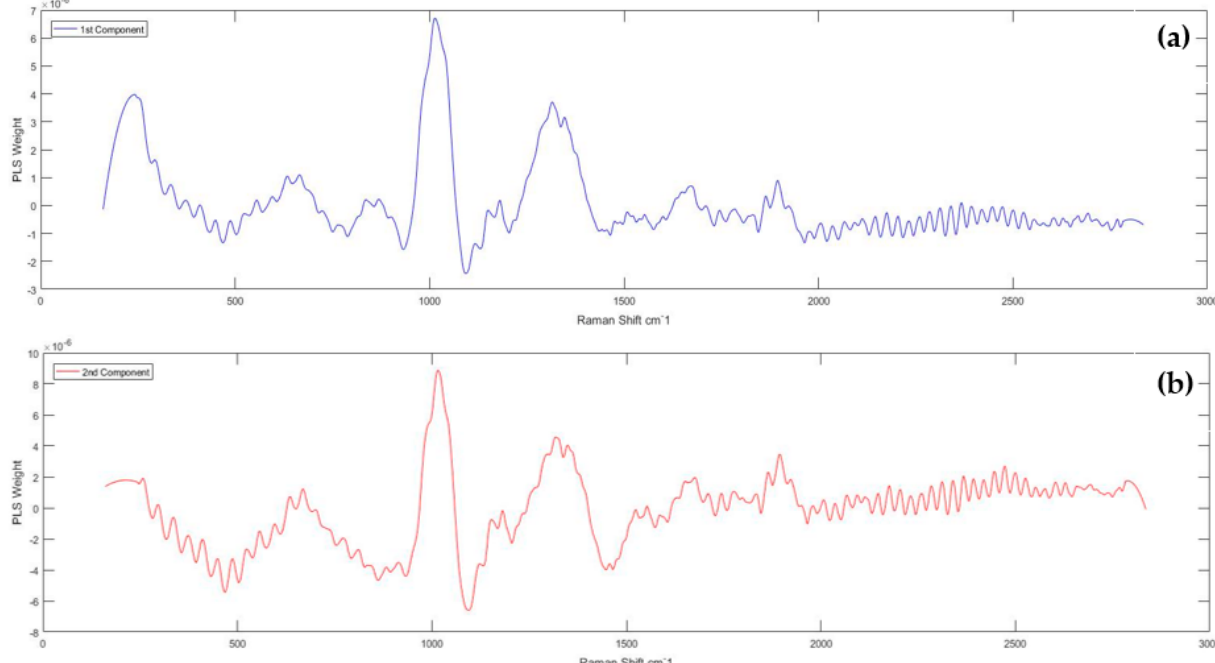
Figure 5. Weight plots from bicarbonate calibration model (4 molar MEA) for ( a ) PLS Component 1 and ( b ) PLS Component 2. The results from performance evaluation are further supported by observing the regression plots. A good model shall have the datapoints distributed along the regression line. Examples of regression plots are depicted in Figure 6, taken from calibration models for 3 molar MEA concentration. It was observed that the datapoints are well-distributed along the straight line on all models. There was no noticeable trending observed in the distribution of datapoints, indicating that the current model is sufficiently parametrized in explaining the variance in the data. A small deviation was observed between actual and predicted datapoints which was reflected by the resulting RMSEC and RMSEV